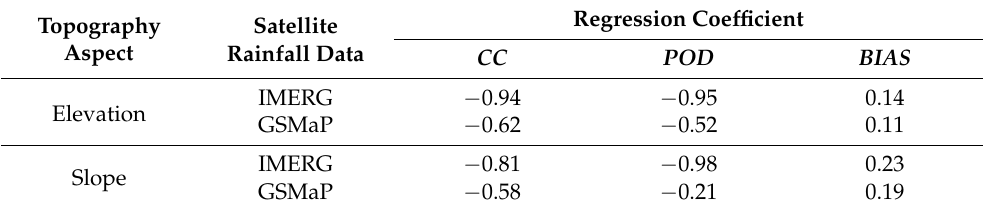
Table 8. Single regression analysis between topographic variables and CC , POD , and BIAS ,